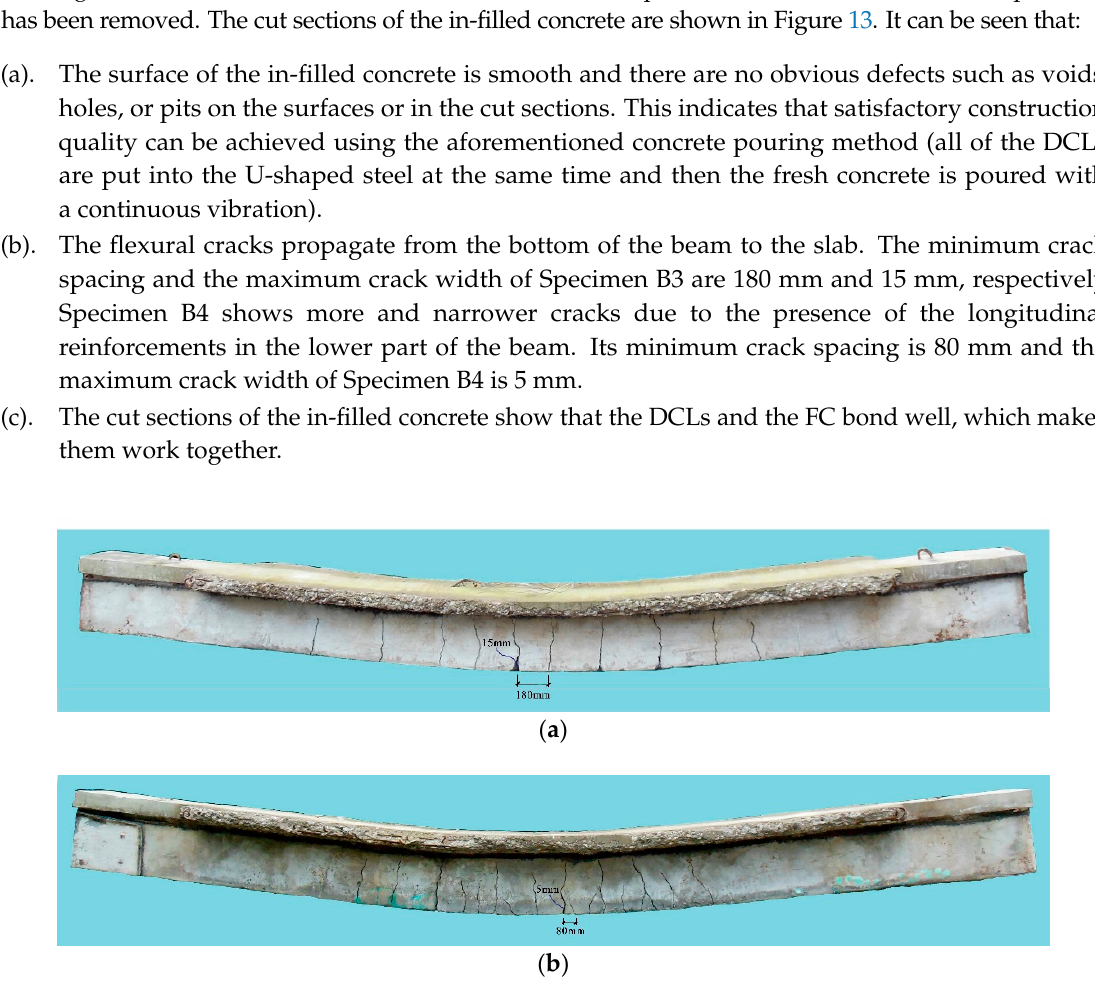
Figure 12. Surface features of in-filled concrete after the fire test: ( a ) Specimen B3 and ( b ) Specimen B4.